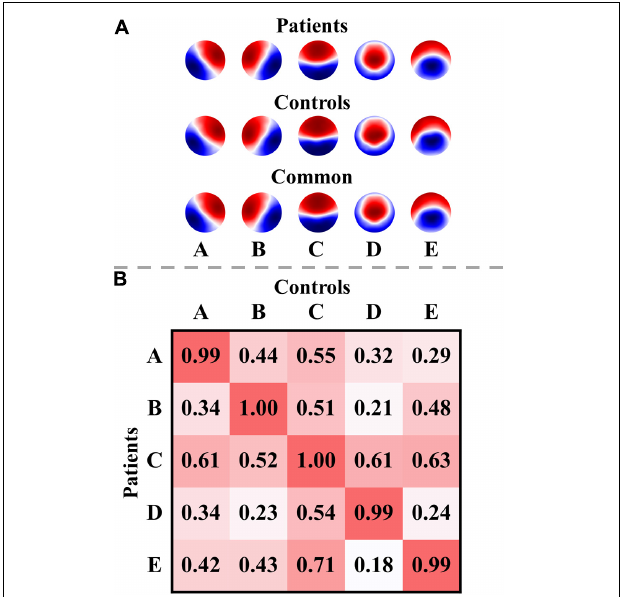
FIGURE 2 | Microstate templates and spatial correlations. (A) Microstate templates. (B) Spatial correlations between the microstate templates of patients and controls. Polarity was ignored when computing the correlations. The templates of the patients were calculated from all their EEG data at T0 and